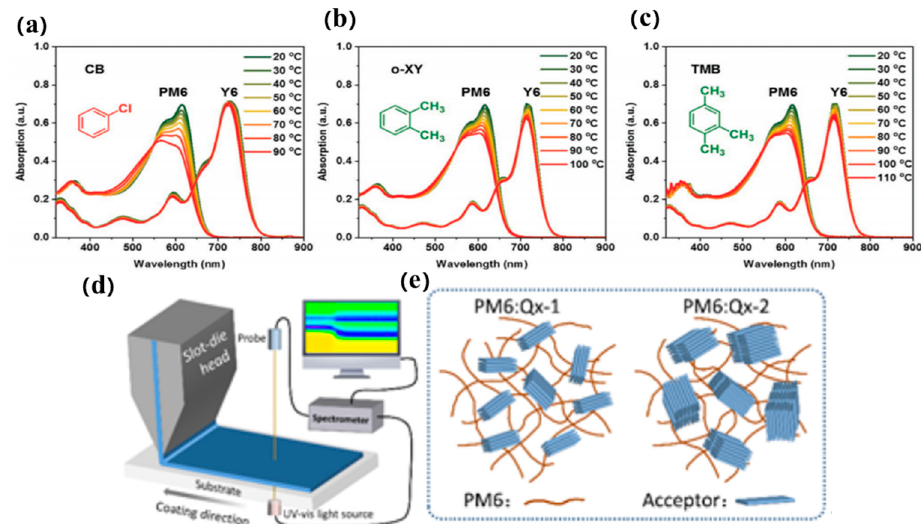
Figure 9. Temperature-dependent UV–vis absorption spectra of PM6 and Y6 in ( a ) CB, ( b ) o − XY, and ( c ) TMB. Adapted with permission from Ref. [54]. Copyright 2020 Wiley − VCH. ( d ) Schematic illustration of in situ UV − vis absorption measurement and slot-die coating process, ( e ) Diagram of the morphology of PM6: Qx-1 and PM6: Qx − 2. Adapted with permission from Ref. [29]. Copyright 2022 Wiley − VCH.